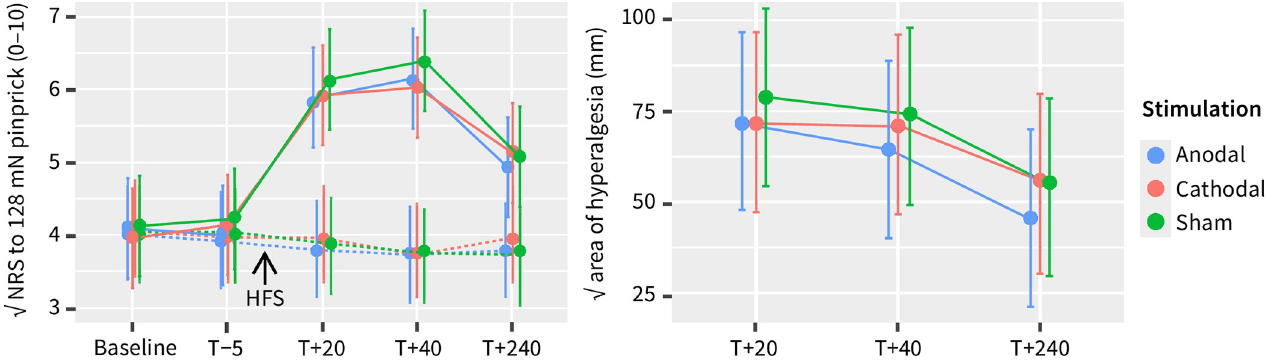
Fig 4. Left: Comparison of the evolution over time of the intensity of perception to mechanical pinprick stimuli at the control (dashed lines) and the HFS (full lines) arm after anodal, cathodal, and sham multifocal tDCS. Right: Comparison of the evolution over time of the square root of the area of secondary hyperalgesia (area in which the intensity of perception to mechanical pinprick stimuli was increased after HFS) after anodal, cathodal, and sham multifocal tDCS. In both panels, the data presented are estimated marginal means and 95% confidence intervals.